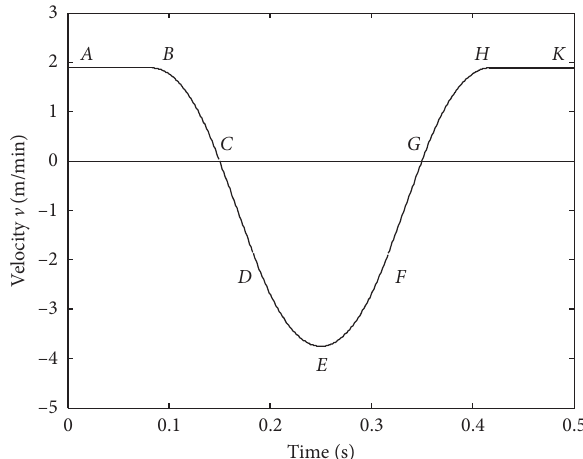
Figure 1: Sketch of velocity curve for nonsinusoidal oscillation.